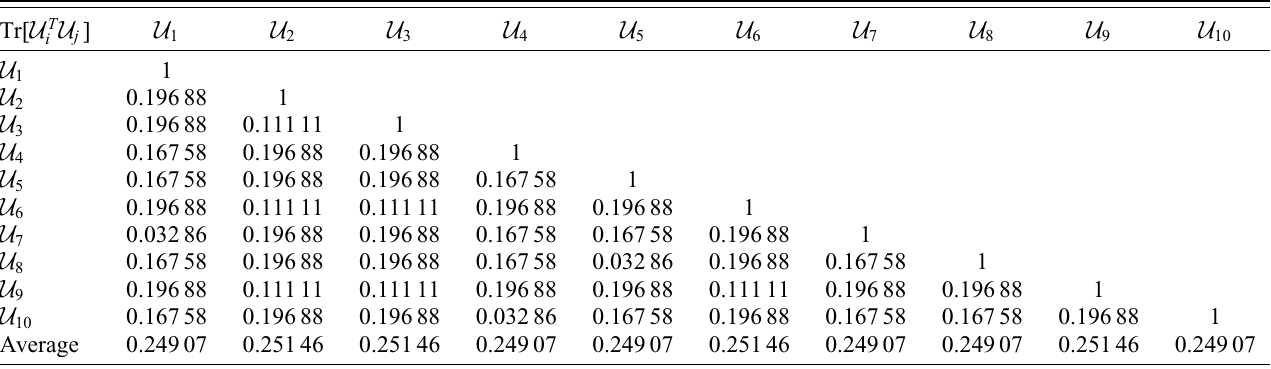
TABLE III. The Hilbert-Schmidt overlap between each element of the numerically constructed (approximate) MUUB. We find this to be the most uniformly overlapping unitary basis possible and thus optimal for